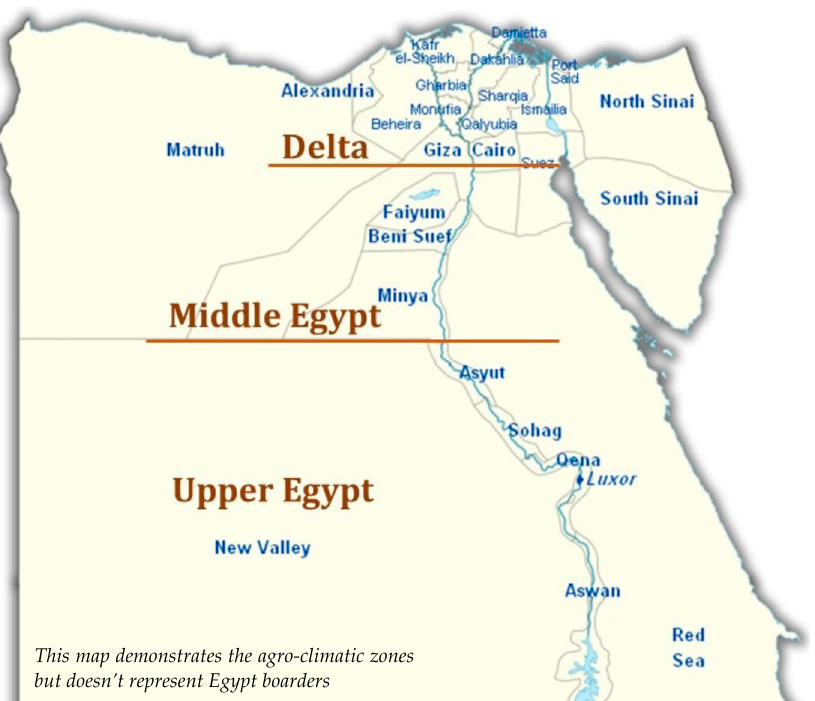
Figure 1. The three different investigated agro-regions; Nile Delta, Middle, and Upper Egypt.